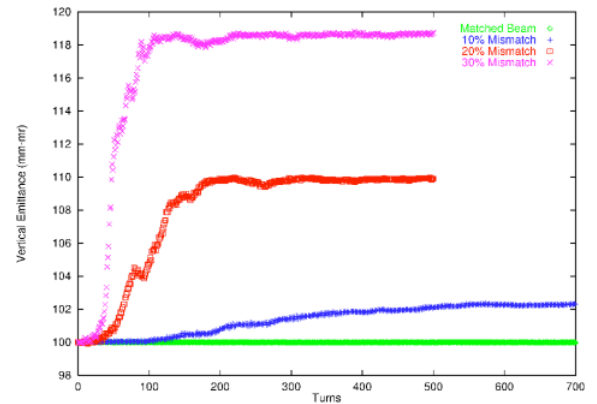
FIG. 8. (Color) Vertical emittance evolution for four levels of rms beam mismatch. Increased beam mismatch yields strongly increased emittance growth due to halo formation.